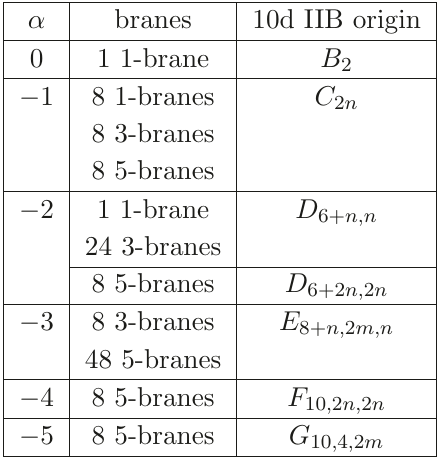
Table 10 . The branes of the IIB theory compactified on T 4 / Z 2 and their corresponding ten- dimensional origin in terms of mixed-symmetry